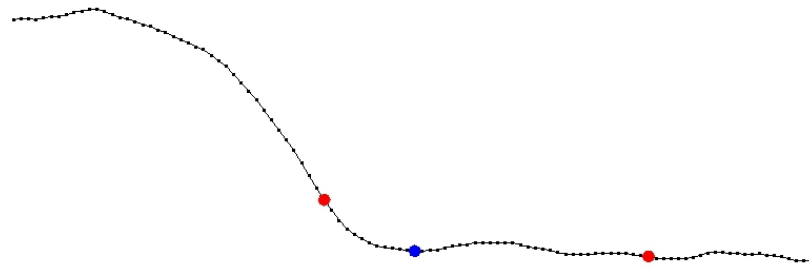
Figure 14. The right bank is set at a predefined horizontal distance from the invert.